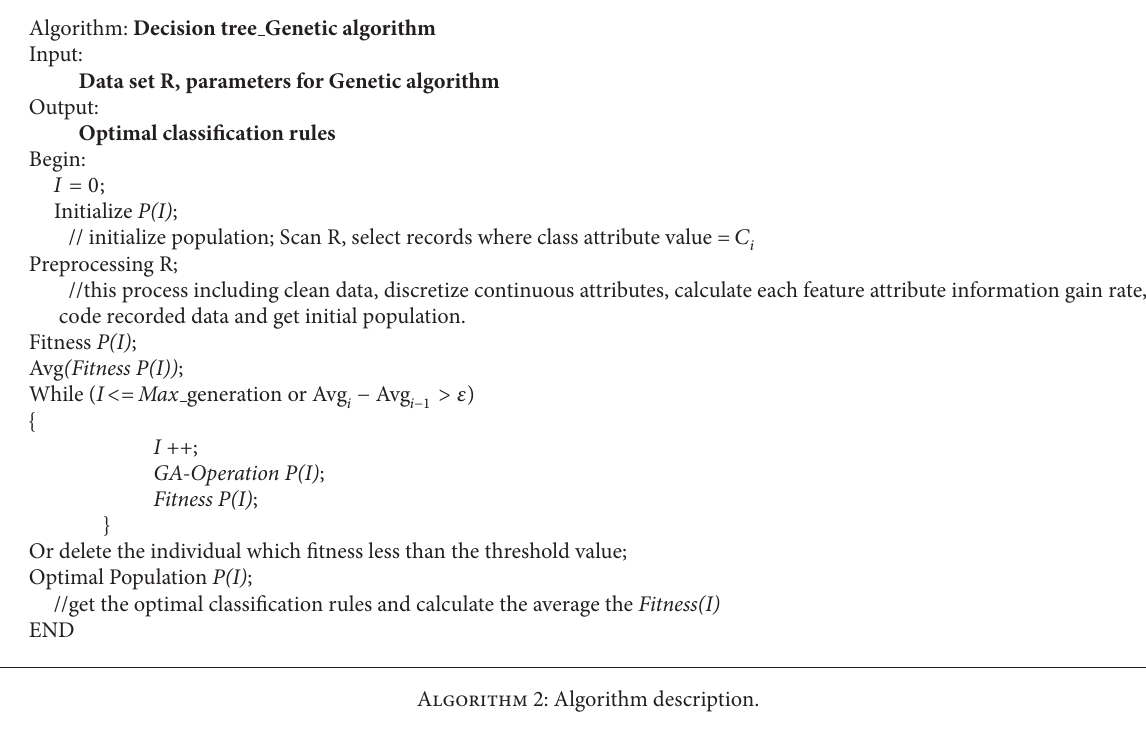
Algorithm: Decision tree Genetic algorithm